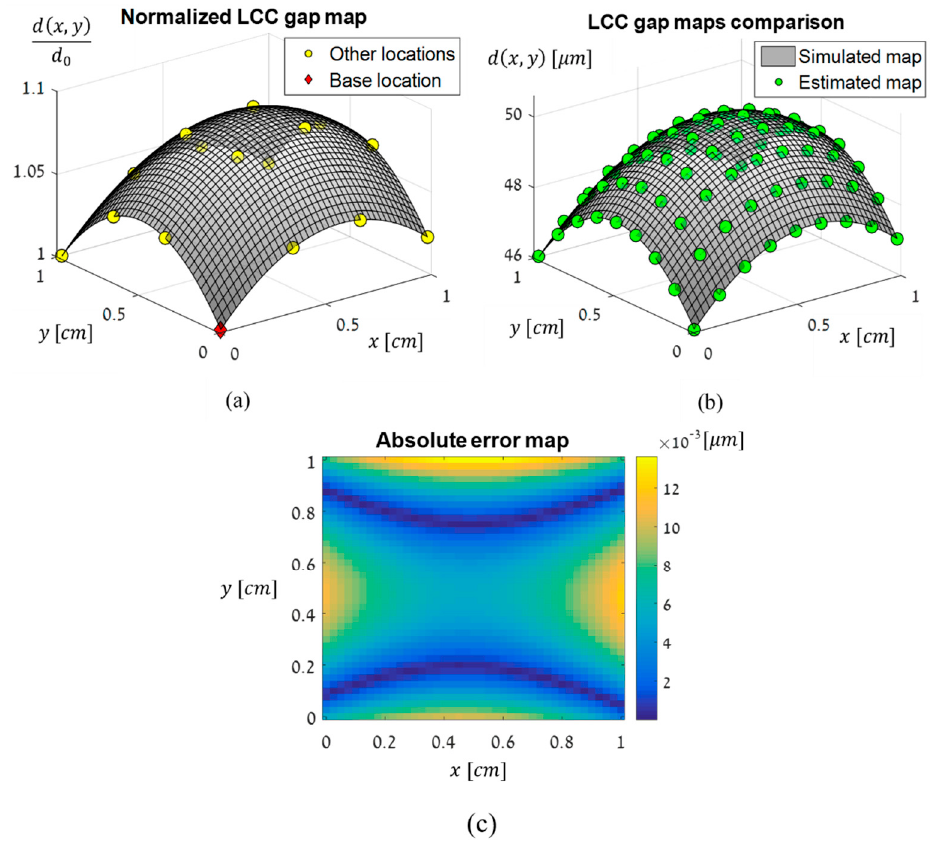
Figure 7. ( a ) The normalized estimated LCC gap map obtained in the simulation. The base location is marked with a red diamond, and the other locations with yellow circles. The map was formed at a single randomly chosen voltage. d 0 is the gap at the base location, and all other gap values are normalized by it. ( b ) The simulated and estimated gap maps layered one on top of the other. The simulated map is plotted as a gray surface, and the estimated map is plotted as green circles at evenly-spaced sampled locations. ( c ) The absolute error map which shows the estimation error across the cell (absolute value of the difference between the two maps in (b)).